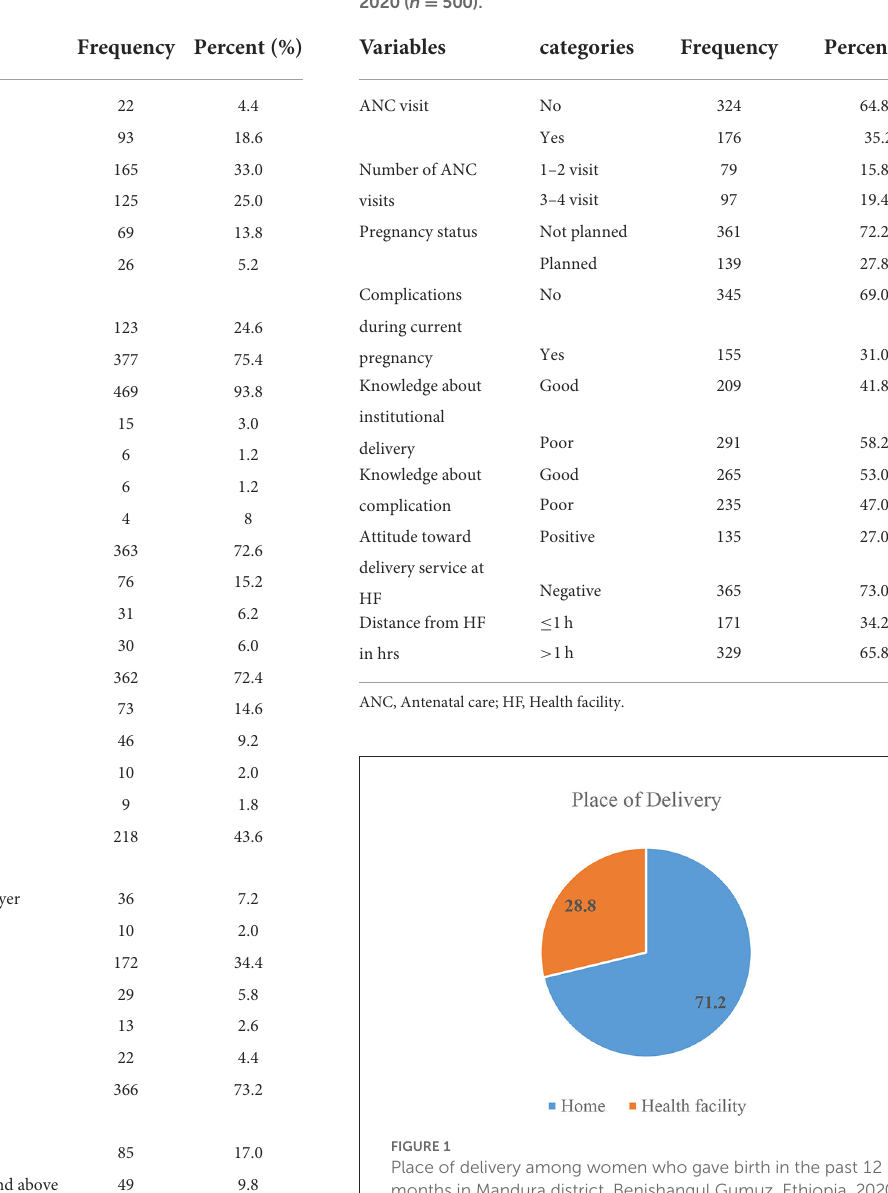
TABLE 1 Socio-demographic characteristics of women who gave birth in the past 12 months in Mandura district, Benishangul Gumuz region, Ethiopia, 2020 ( n = 500).